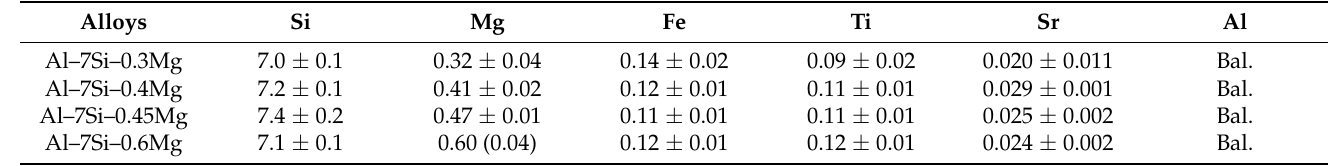
Table 1. At least two batches were prepared for each alloy. Table 1. Average chemical compositions of the Al–7Si–Mg alloys used in this study. Compositions in